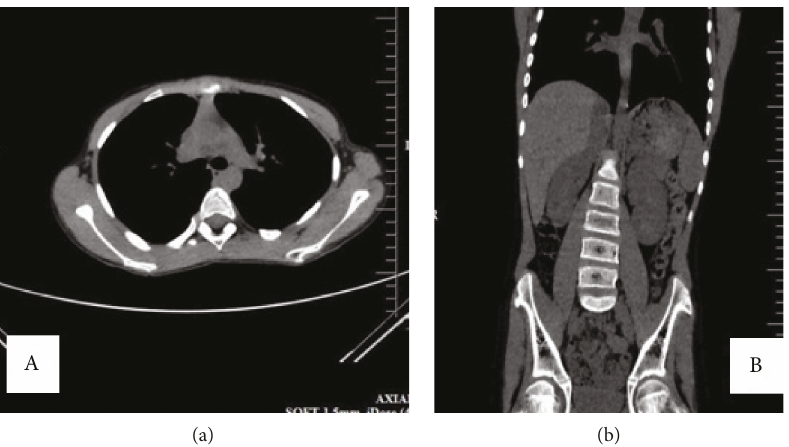
Figure 5: CT scan showing (a) axial section of the chest and pelvis cavity, no metastases detected, and (b) abdomen and chest are